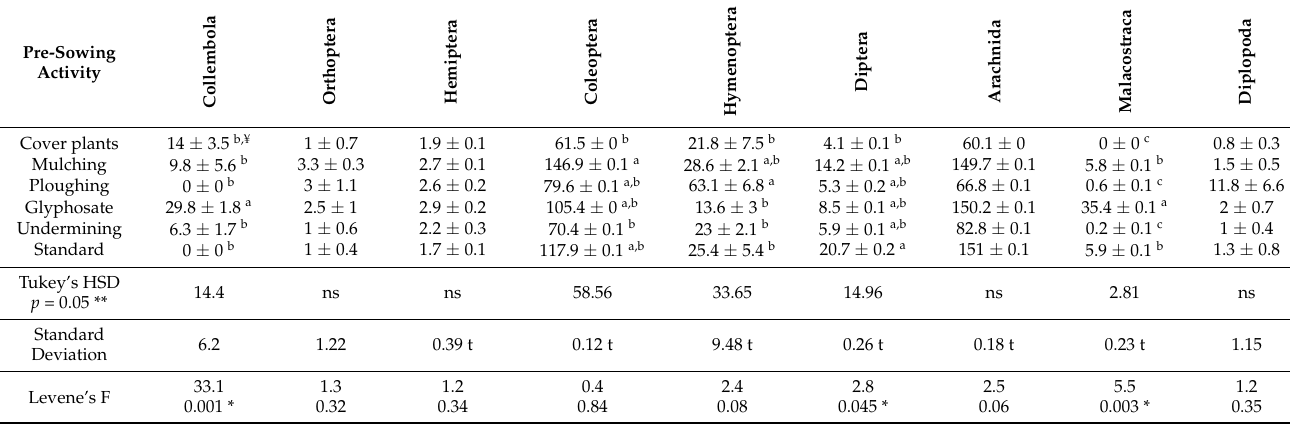
Table 5. Total soil fauna analysed by order/class ( ± SE) collected in April on different tillage systems before sowing.